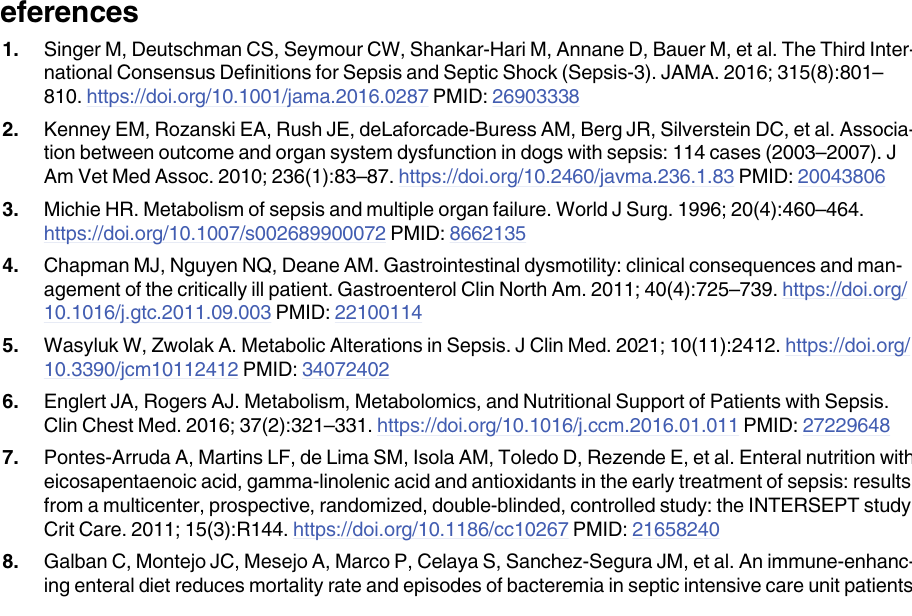
S1 Fig. Scatterplots of correlations between illness severity and select prognostic biomark- ers. Scatterplots were constructed to explore the relationships between illness severity as assessed by the APPLEfast score and prognostic biomarker abundance. Displayed are the 12 biomarkers with the highest degree of correlation with the APPLEfast score. The associated Spearman correlation coefficient (r ) and corresponding unadjusted P-value is displayed inset s on each